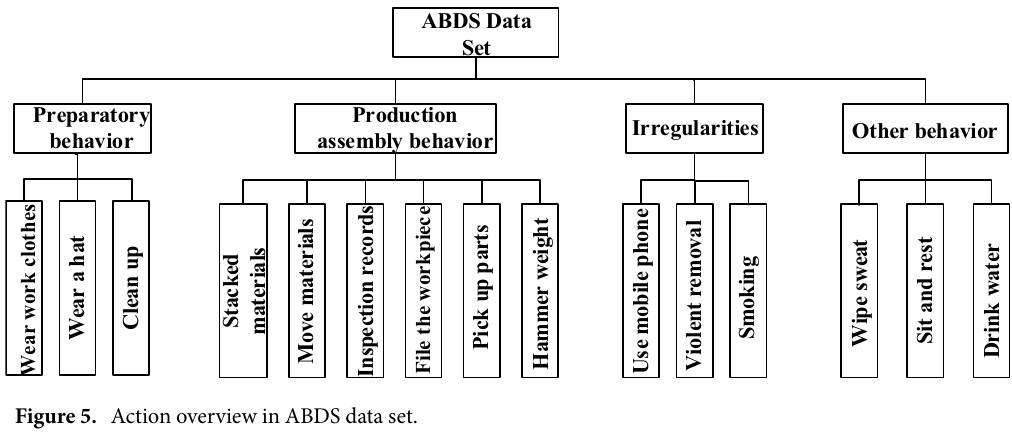
Figure 5. Action overview in ABDS data